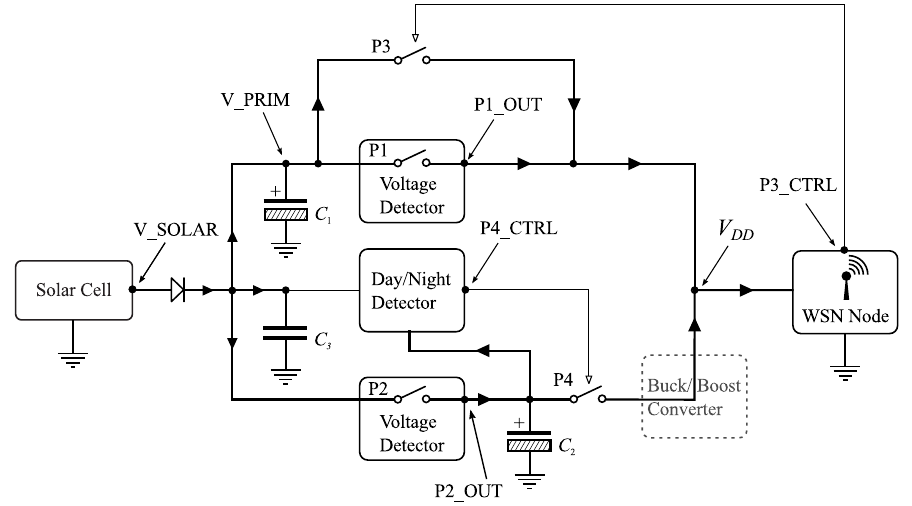
Figure 1. Block diagram of the proposed system: filled arrows indicate energy flow; empty arrows indicate control